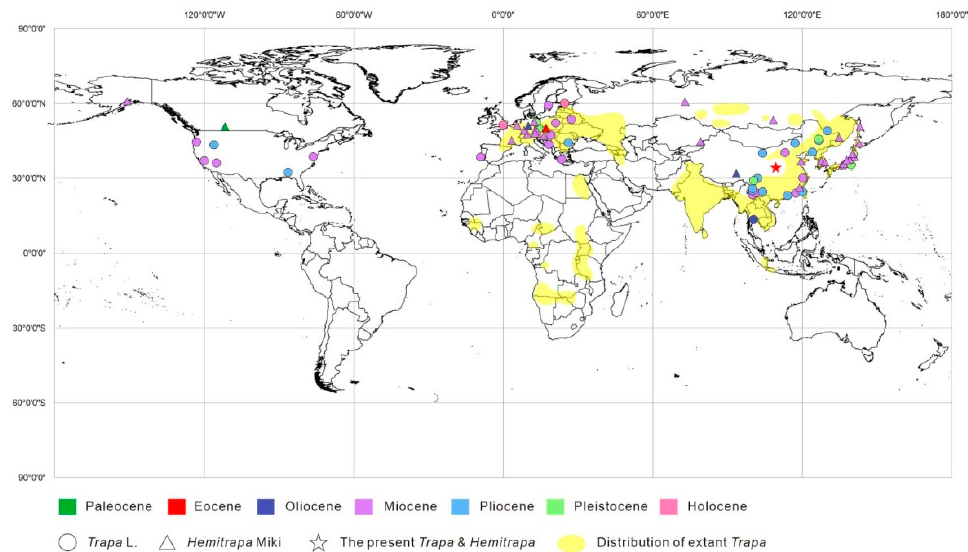
Figure 4. Fossil fruit records of Trapa L. and Hemitrapa Miki were reported throughout the Northern Hemisphere, and the distribution of extant Trapa . Trapa fossil records, except for China, are based on Graham [3] while those from China are based on Aung et al. [49]. The fossil distribution of Hemitrapa is modified from Su et al. [32]. Distribution of extant Trapa is modified from Mai [74]. The star represents the fossil Trapa and Hemitrapa investigated in this study. The map was created using ArcGIS